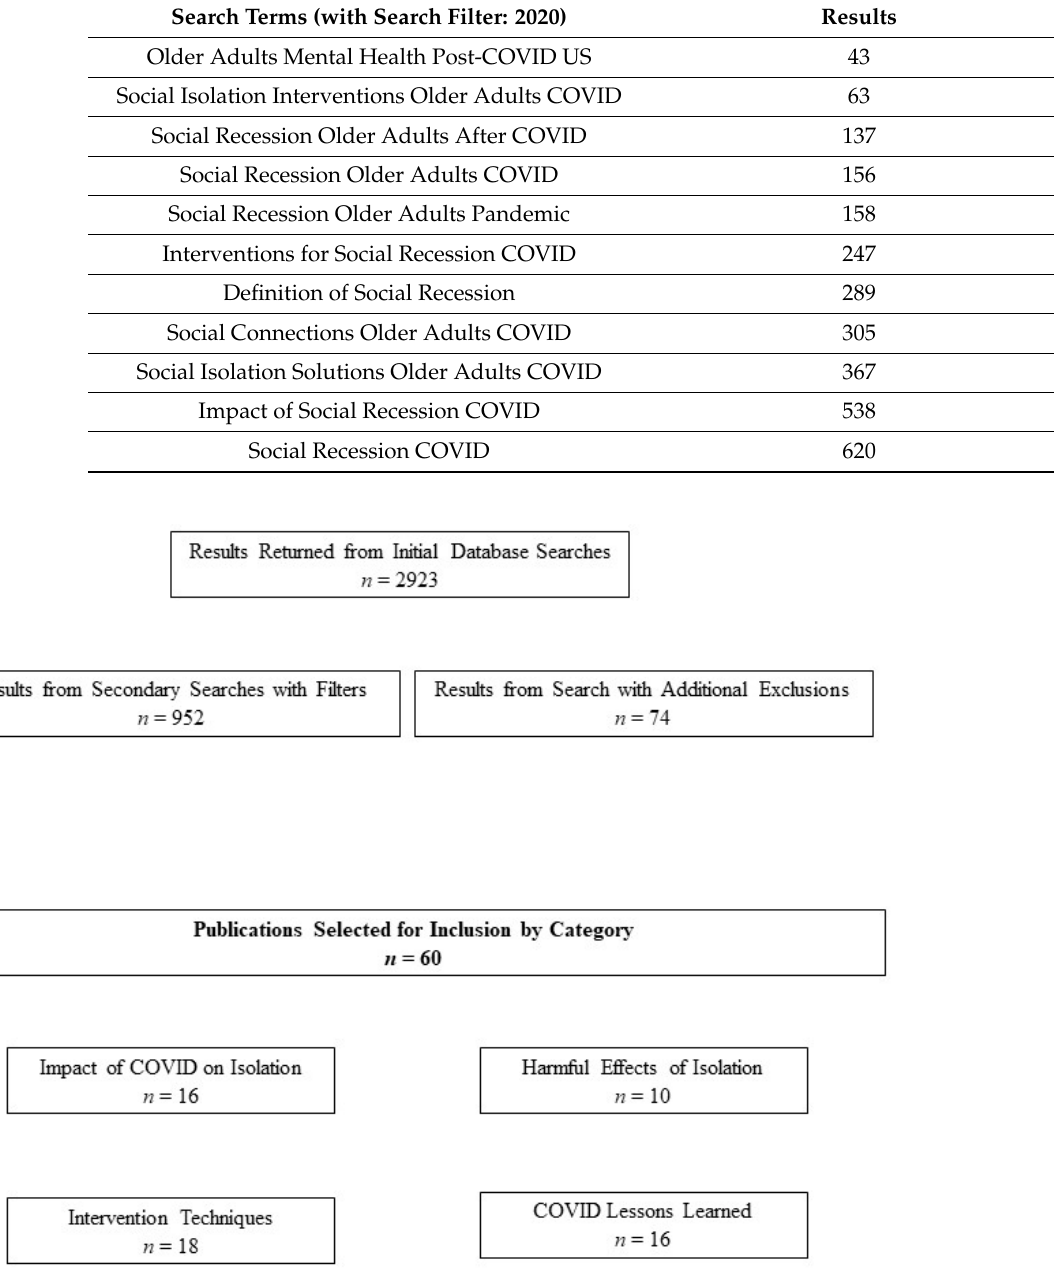
Figure 1. Diagram Displaying Search Methods and